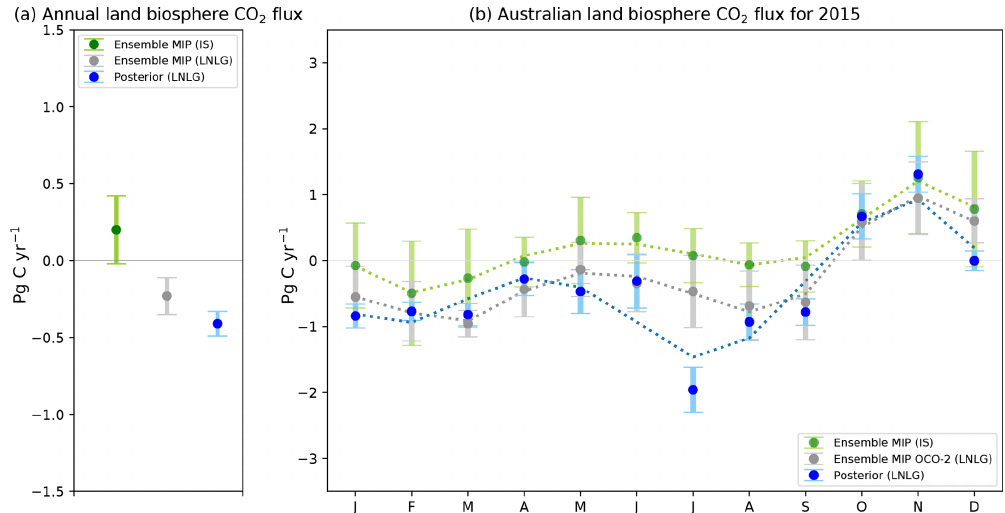
Figure 14. Panel (a) shows the ensemble annual mean of carbon fluxes derived by the in situ (green dot) and OCO-2 (LNLG) MIP (grey dot) global inversions, and the annual mean of the posterior fluxes estimated in this study (blue dot). The green and grey error bar represents the annual ensemble spread of the global models. In contrast, the blue error bar represents the uncertainties in the posterior flux calculated by different OSSEs estimated by Villalobos et al. (2020). Panel (b) shows the ensemble mean seasonal cycle of MIP in situ (green dots) and OCO-2 (LNLG) (grey dots) and the seasonal cycle of the posterior fluxes estimated in this study (blue dots) (all fluxes in this comparison are without fossil fuel emissions).